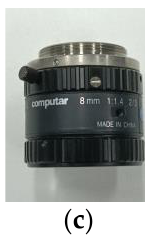
Figure 1. Daheng Industrial Camera: ( a ) overall camera; ( b ) camera base; ( c ) camera lens. Table 2. The basic parameters of the industrial camera.